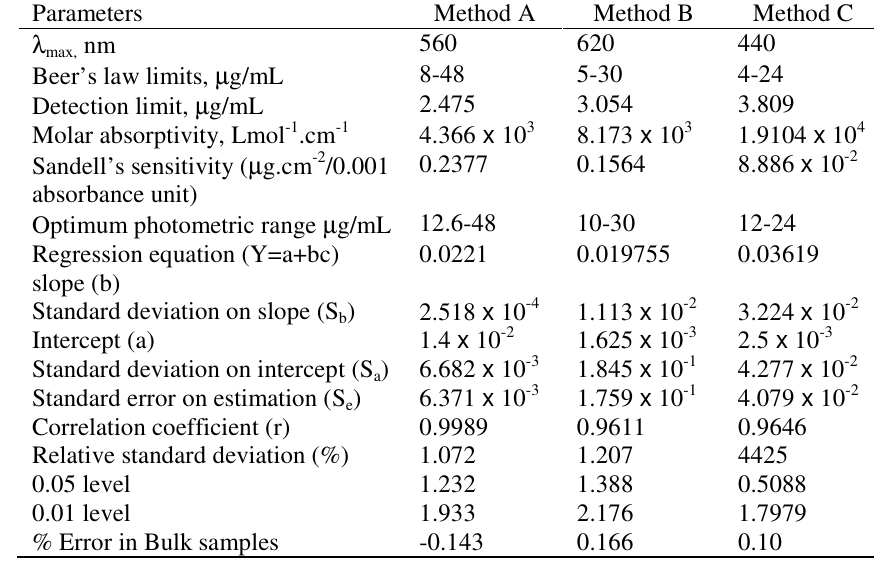
Table 2. Optical and regression characteristics, precision and accuracy of the proposed methods for